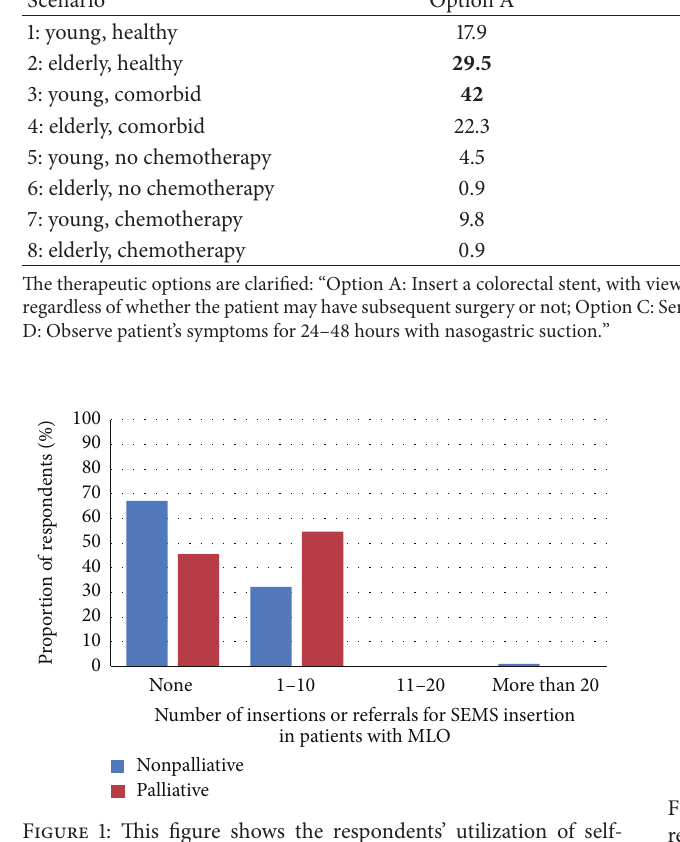
Figure 1: This figure shows the respondents’ utilization of self- expandable metallic stents (SEMS) in the management of malignant large bowel obstruction (MLO) in palliative and nonpalliative settings in the twelve months prior to the survey.